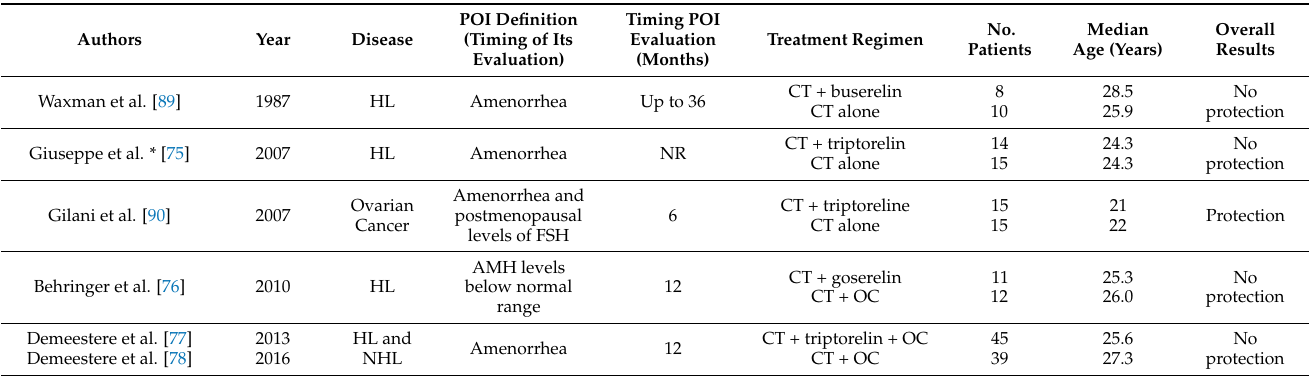
Table 3. Randomized trials evaluating temporary ovarian suppression with GnRHa during chemotherapy in patients with malignancies other than breast